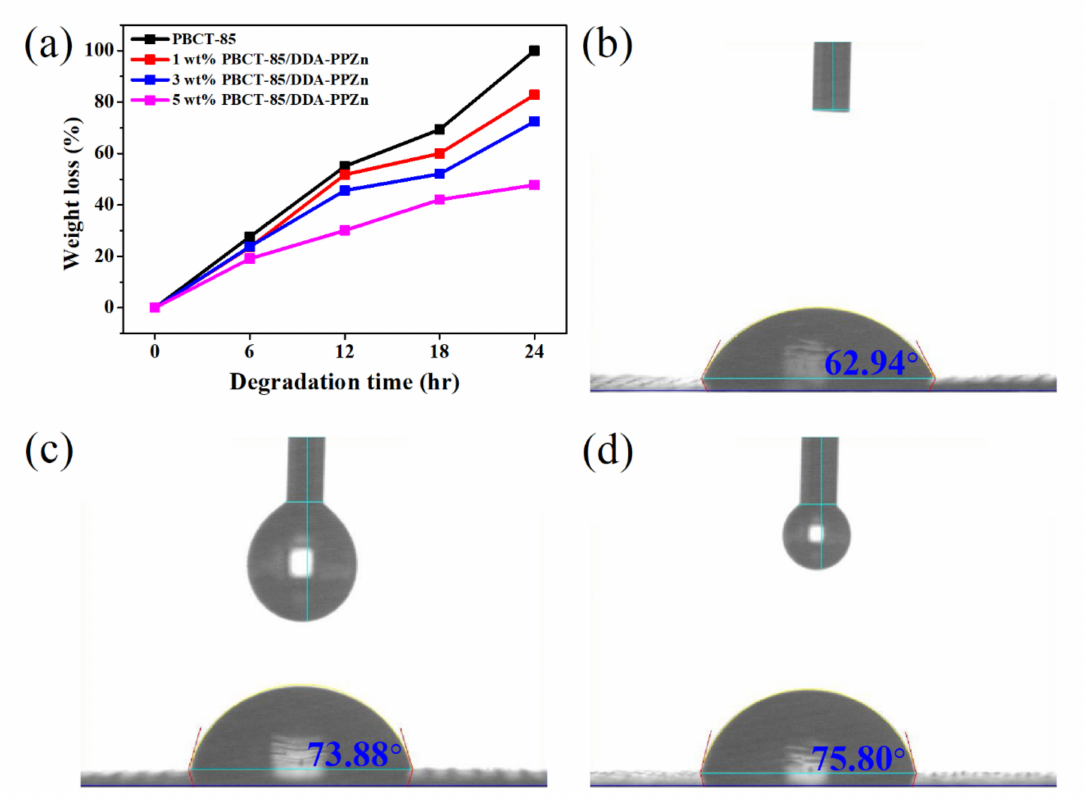
Figure 8. ( a ) Dependence of the weight loss on the degradation time for the PBCT-85 / DDA-PPZn nanocomposites. Contact angles of ( b ) PBCT, ( c ) PBCT-85 / DDA-PPZn, and ( d ) PBCT-85 / ODA-PPZn